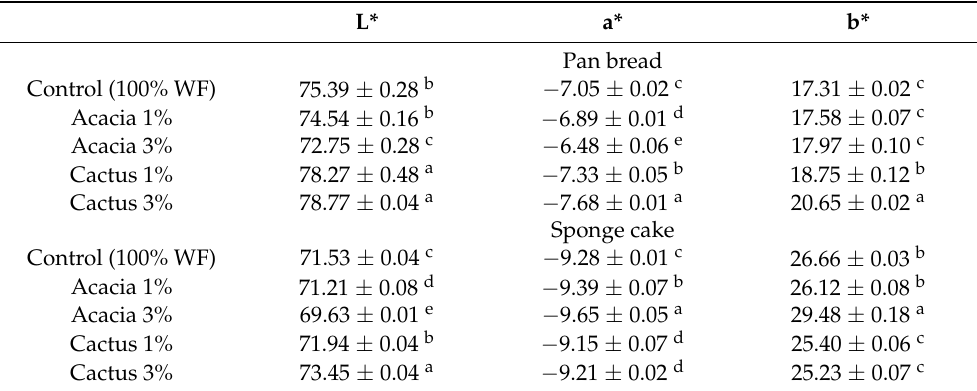
Table 4. Effect of acacia and cactus gums on the crumb-color parameters of bread and cake